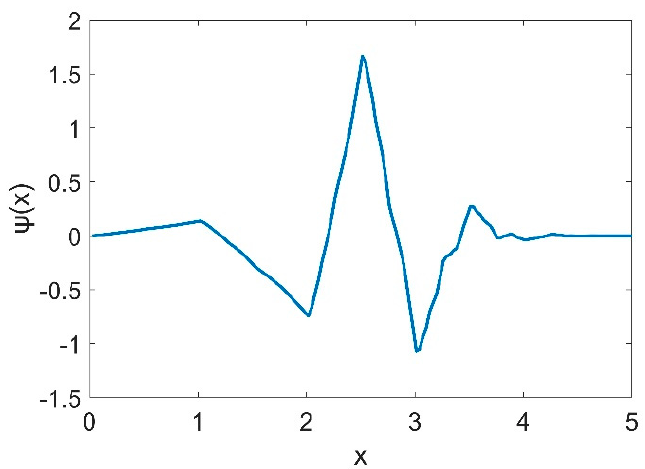
Figure 4. The order 3 Daubechies wavelet (DB3).